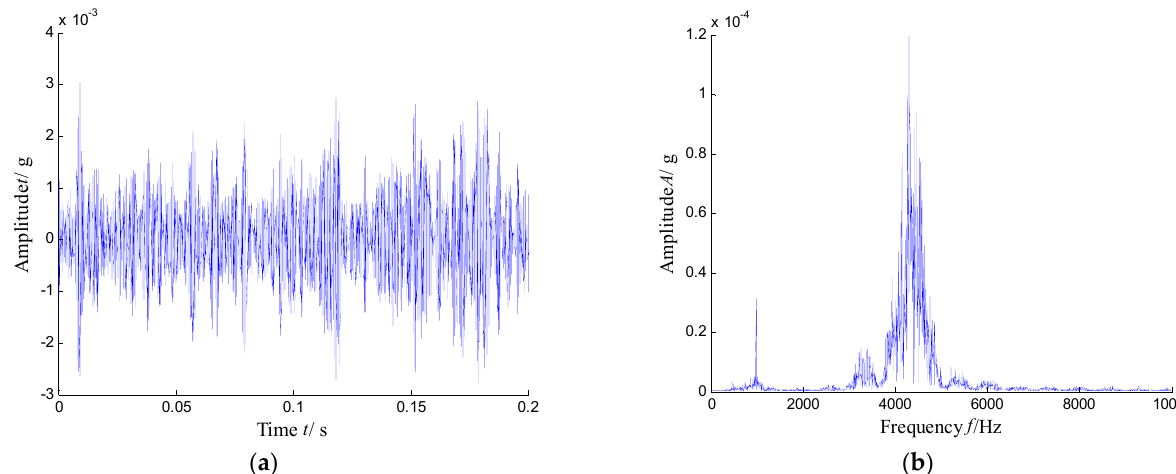
Figure 11. Envelope spectrum of the filtered signal.